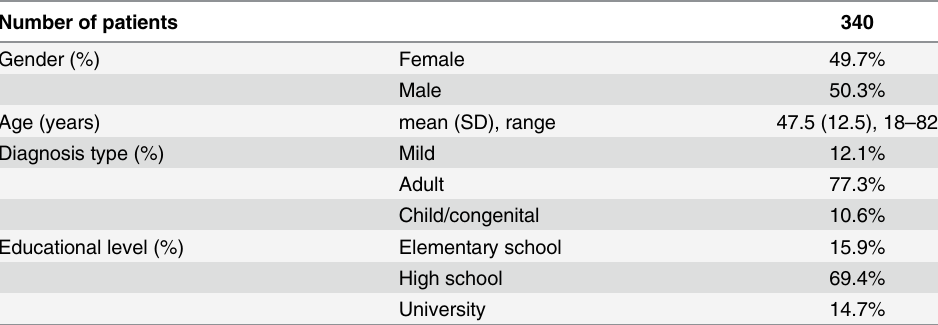
Table 1. Basic characteristics of patients with